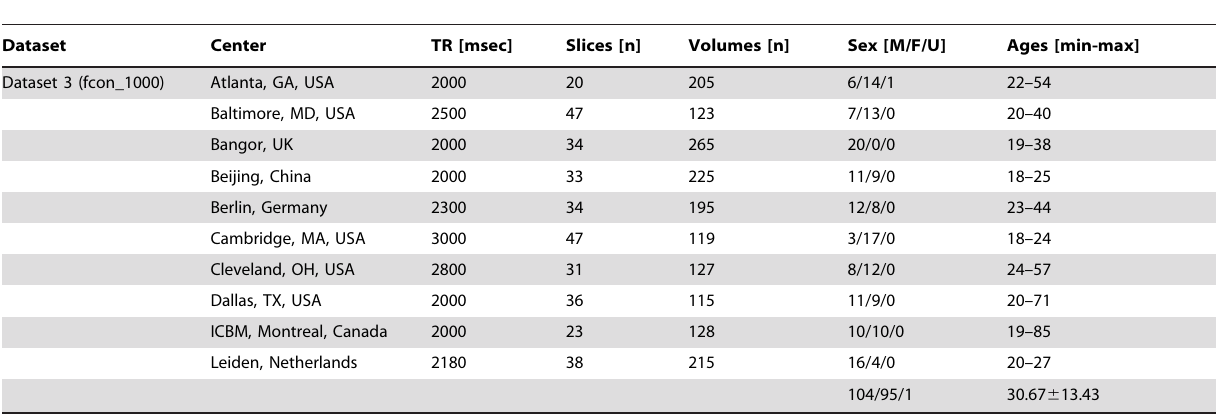
Table 2. Core characteristics of dataset 3 (resting state functional